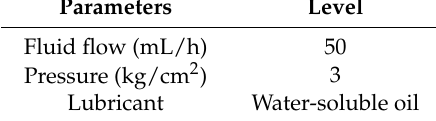
Table 7. The MQL